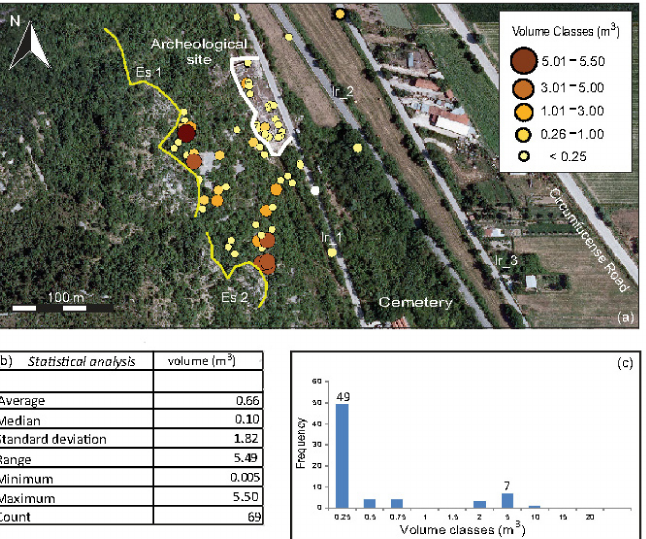
Figure 5. ( a ) Rock block inventory map. Volume classes are reported in the upper right box. Yellow lines represent the traces of the main rock escarpments Es1 and Es2; ( b ) basic statistical analysis; ( c ) frequency